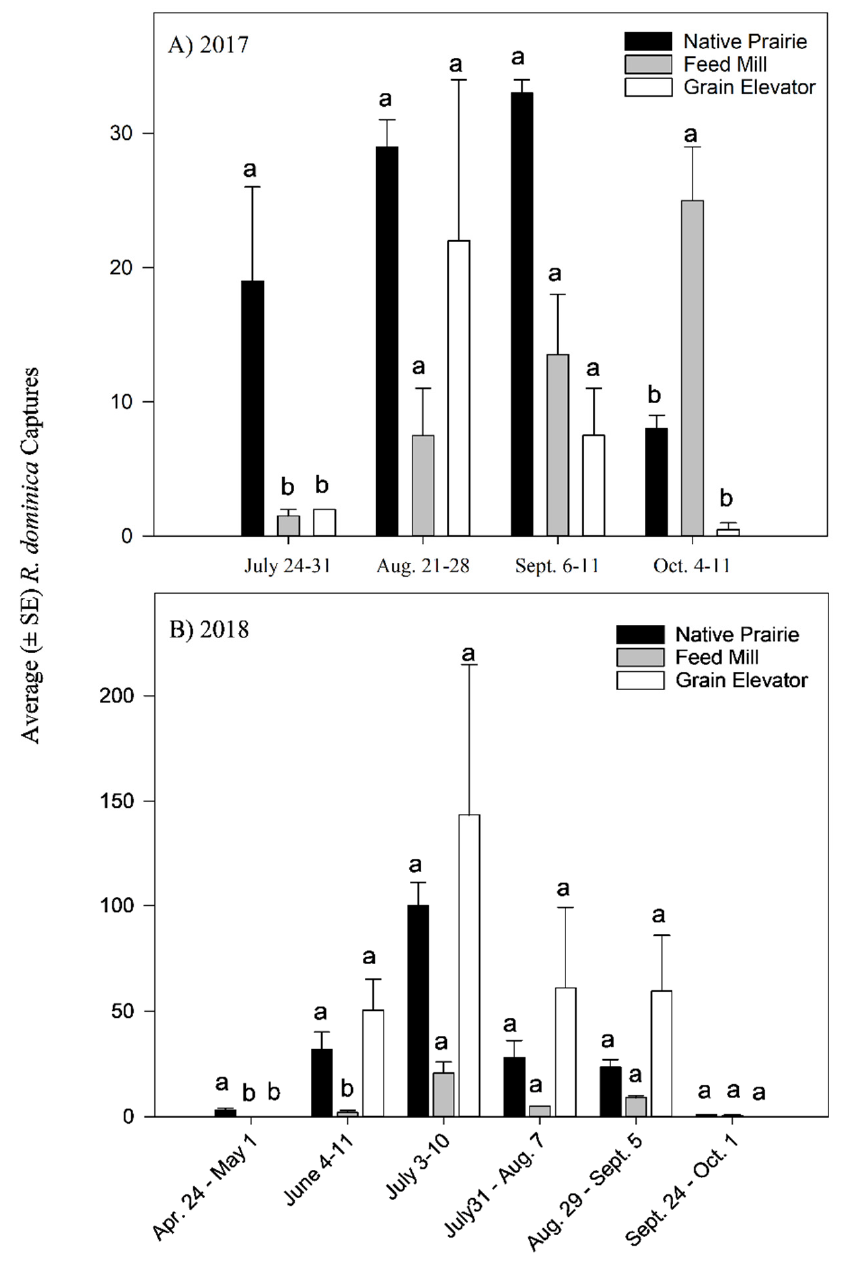
Figure 2. Mean ( ± SE) Rhyzopertha dominica captures in Delta sticky traps during a 7 d trapping period repeated monthly for ( A ) 2017 and ( B ) 2018. The black bars represent the native prairie, gray bars represent the feed mill, and the white bars are the grain elevator. Different letters for each trapping date denote significant differences between the trapping locations ( p < 0.05, Tukey studentized range (HSD) test).